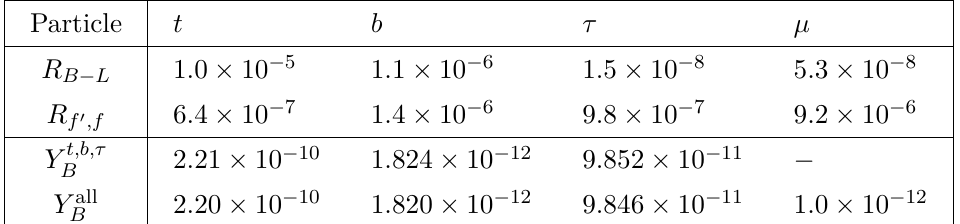
Table 3. For each fermion: relative difference between baryon and lepton number (first row) and between an eigenvector of a particle density and its derivative (second row); prediction of Y B with t, b, τ, u, h (third row) participating in the transport equations, and with all SM particles including µ (fourth row), for T f = 0 , T f = ± 0 . 05 R I